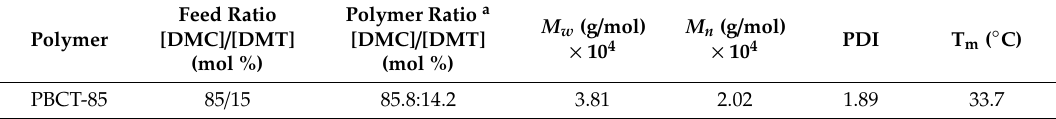
Figure 1. 1 H-nuclear magnetic resonance (H-NMR) spectra of the poly (butylene carbonate-co- terephthalate) (PBCT-85) copolyester. Table 1. Composition and molecular weight of synthesized